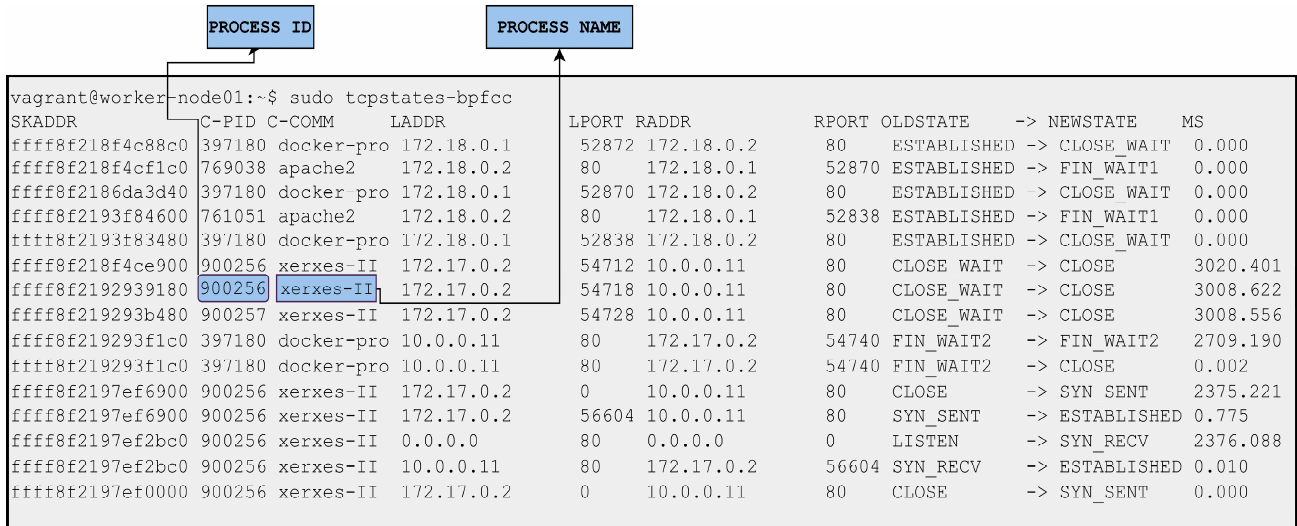
Figure 3. Observation of the attack on the target node.